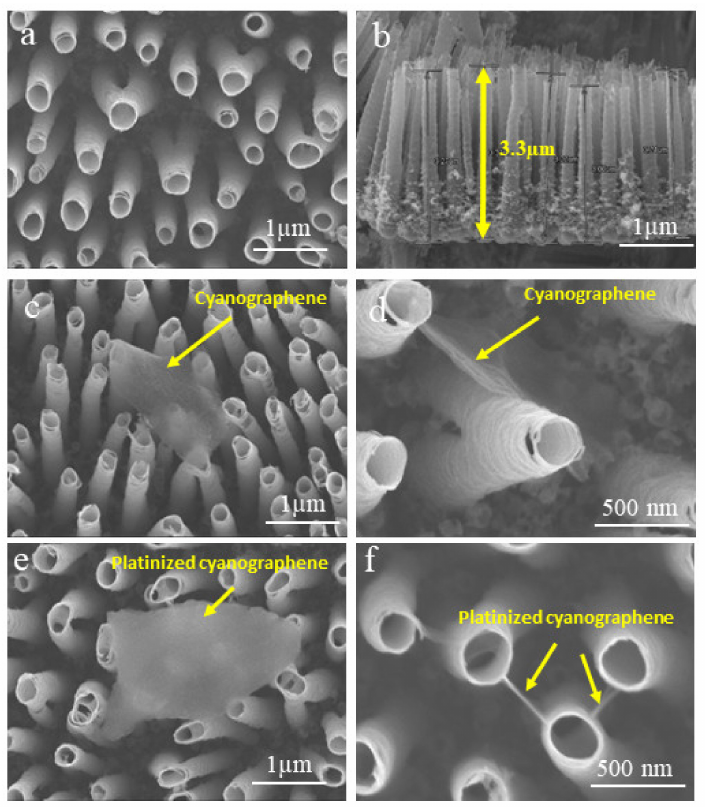
Figure 2. SEM images of samples: ( a ) P-NTs, ( b ) showing cross-section of P-NTs, ( c , d ) GNTs, ( e , f )